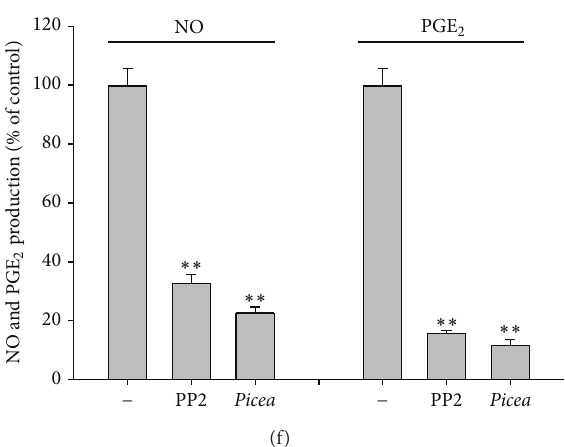
Figure 4: The mode of inhibition of Src kinase activity by luteolin. ((a), (b), and (e)) HEK293 cells (5 × 10 6 cells/mL) were transfected with Src-WT, Src-KD, Src-CA, Src-dSH2, Src-dSH3, Src-D404A, Src-K295A, or Src-M341G in the presence or absence of luteolin. After preparing whole lysates, the levels of total or phosphorylated Src, HA, and 𝛽 -actin were determined by immunoblotting. (c) Kinase assays were performed using immunoprecipitated Src as the enzyme, and immunoprecipitated p85 as the substrate, in the presence of ATP and luteolin. Src activity was determined by measuring the levels of phospho-p85 by immunoblotting analysis. (d) The putative binding site of luteolin in the ATP-binding pocket of Src. (f) The inhibitory effects of PP2 or piceatannol ( Picea ) on the production of NO or PGE 2 were examined using the Griess assay and EIA. All data are expressed as the mean ± SD of experiments that were performed with six or three samples. ∗ 𝑝 < 0.05 and ∗∗ 𝑝 < 0.01 compared to the control group.